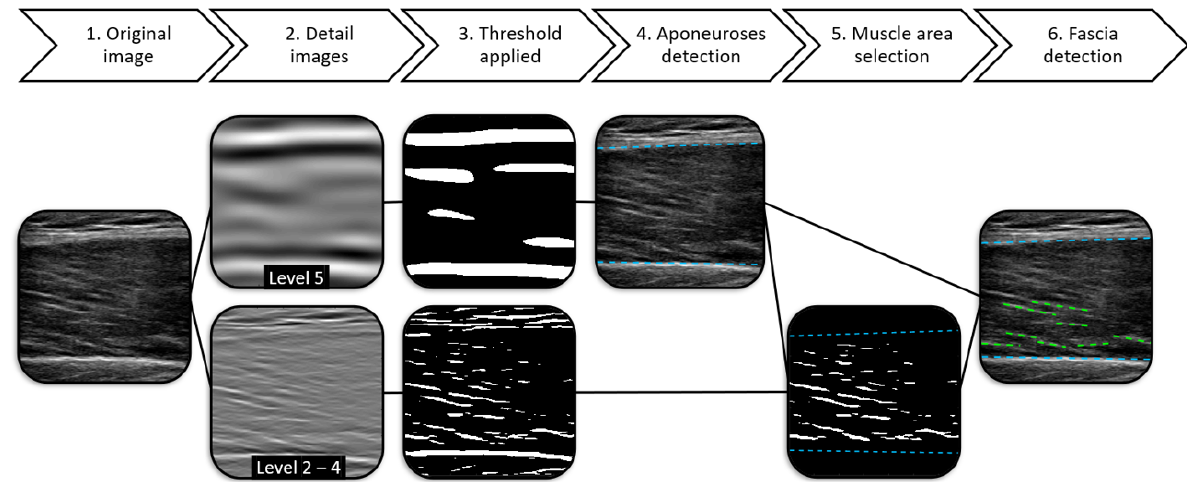
Figure 2. The workflow of the muscle architecture detection. ( 1 ) The original image ( 2 ) is decomposed into five oriented detail images with four orientations. Level 2–4 and level 5 are used for fascicles and aponeuroses detection, respectively. For both, the structure orientation perpendicular to the ultrasound beam is used. ( 3 ) Subsequently, a threshold is applied to the detail images of the aponeuroses and fascicles. ( 4 ) In the aponeuroses detail image, the edges of the anterior and posterior aponeurosis adhering to the muscle are identified, respectively. ( 5 ) Only the region between these aponeuroses is selected for fascicles detection. ( 6 ) The detected aponeuroses and fascicles super imposed onto the original